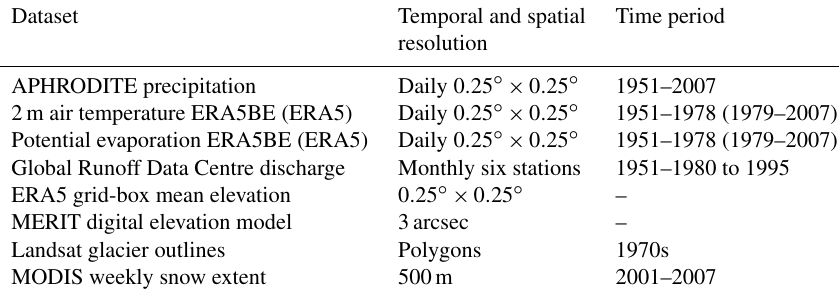
Table 1. Summary of the datasets used for this